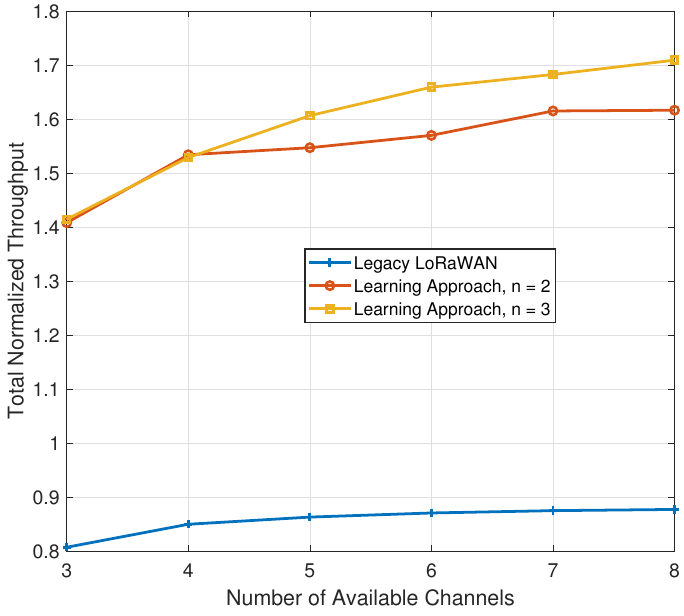
Figure 6. Impact of added channels on the total normalized